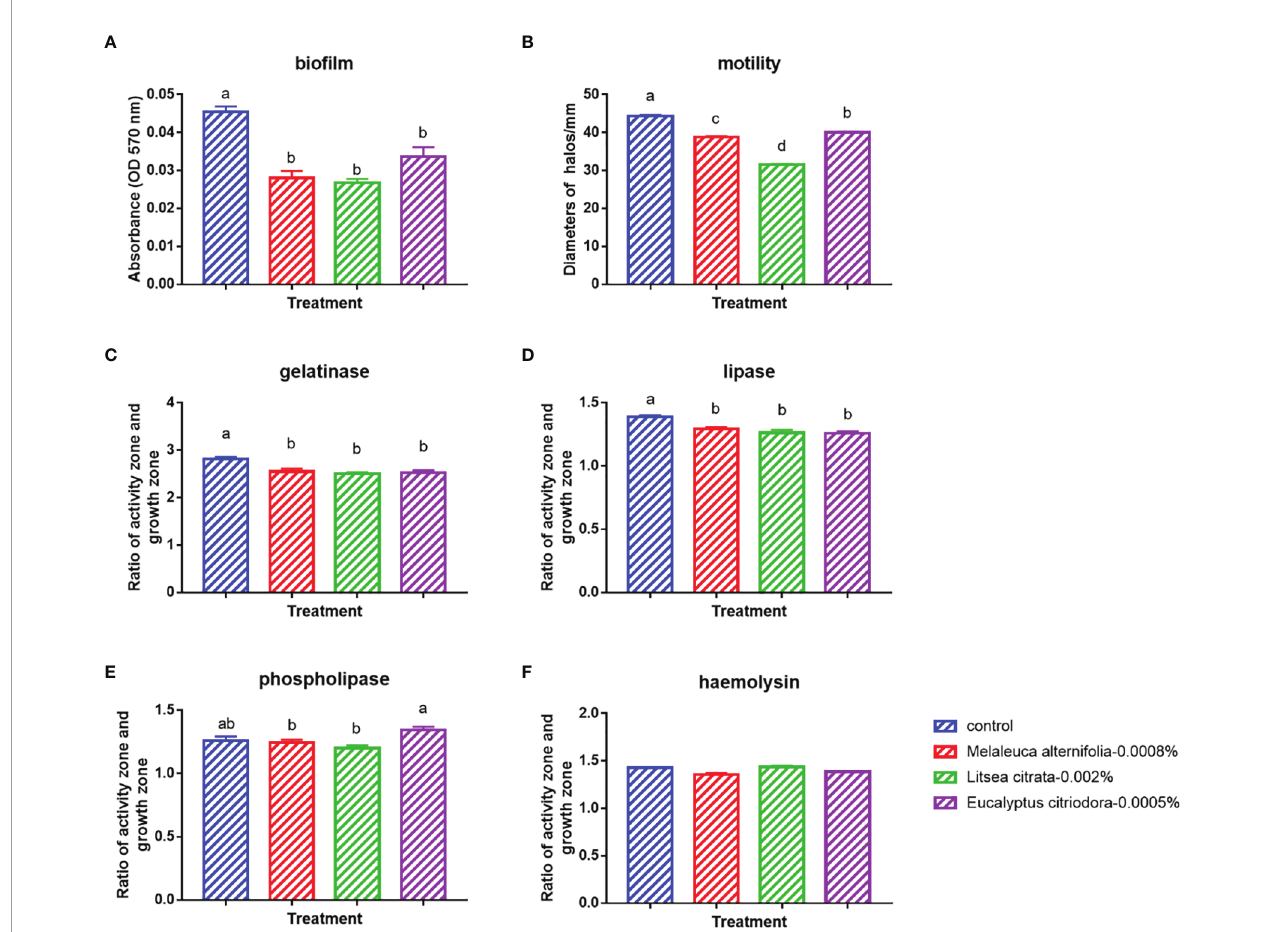
FIGURE 5 | In vitro tests on the bacterial virulence factors of Vibrio campbellii treated with the selected essential oils at an optimized dose. (A) Bio fi lm formation of V. campbellii in marine broth. (B) Swimming motility of V. campbellii on soft LB 35 agar after 24 h of incubation at 28°C. (C) Gelatinase assay of V. campbellii on LB 35 agar supplemented with 0.5% gelatin after 48 h of incubation at 28°C. (D) Lipase assay of V. campbellii on LB 35 agar supplemented with 1% Tween 80 after 2 – 4 days of incubation at 28°C. (E) Phospholipase assay of V. campbellii on LB 35 agar supplemented with 1% egg yolk after 2 – 4 days of incubation at 28°C. (F) Hemolytic assay of V. campbellii on LB 35 agar supplemented with 5% de fi brinated sheep blood after 48 h of incubation at 28°C. Control: no EO added but consisted of 1% of DMSO. The error bars of the graphs represented standard error. Different letters indicated signi fi cant difference ( P <